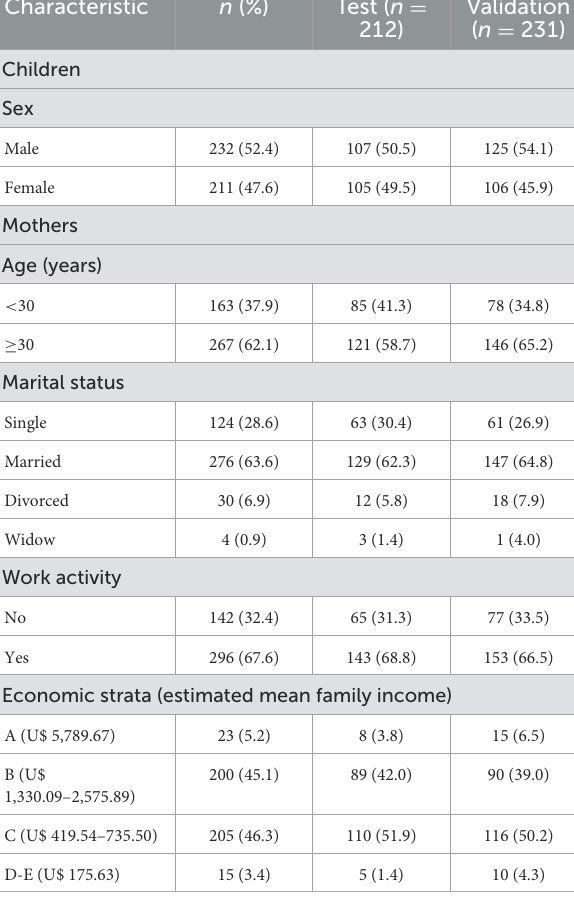
TABLE 1 Demographic characteristics of the study participants.